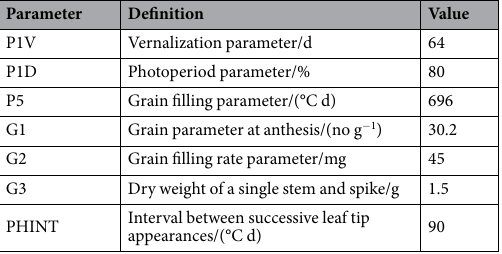
Table 1. Genetic coefficients of the winter wheat cultivar of ‘ Bainong 207 ’.